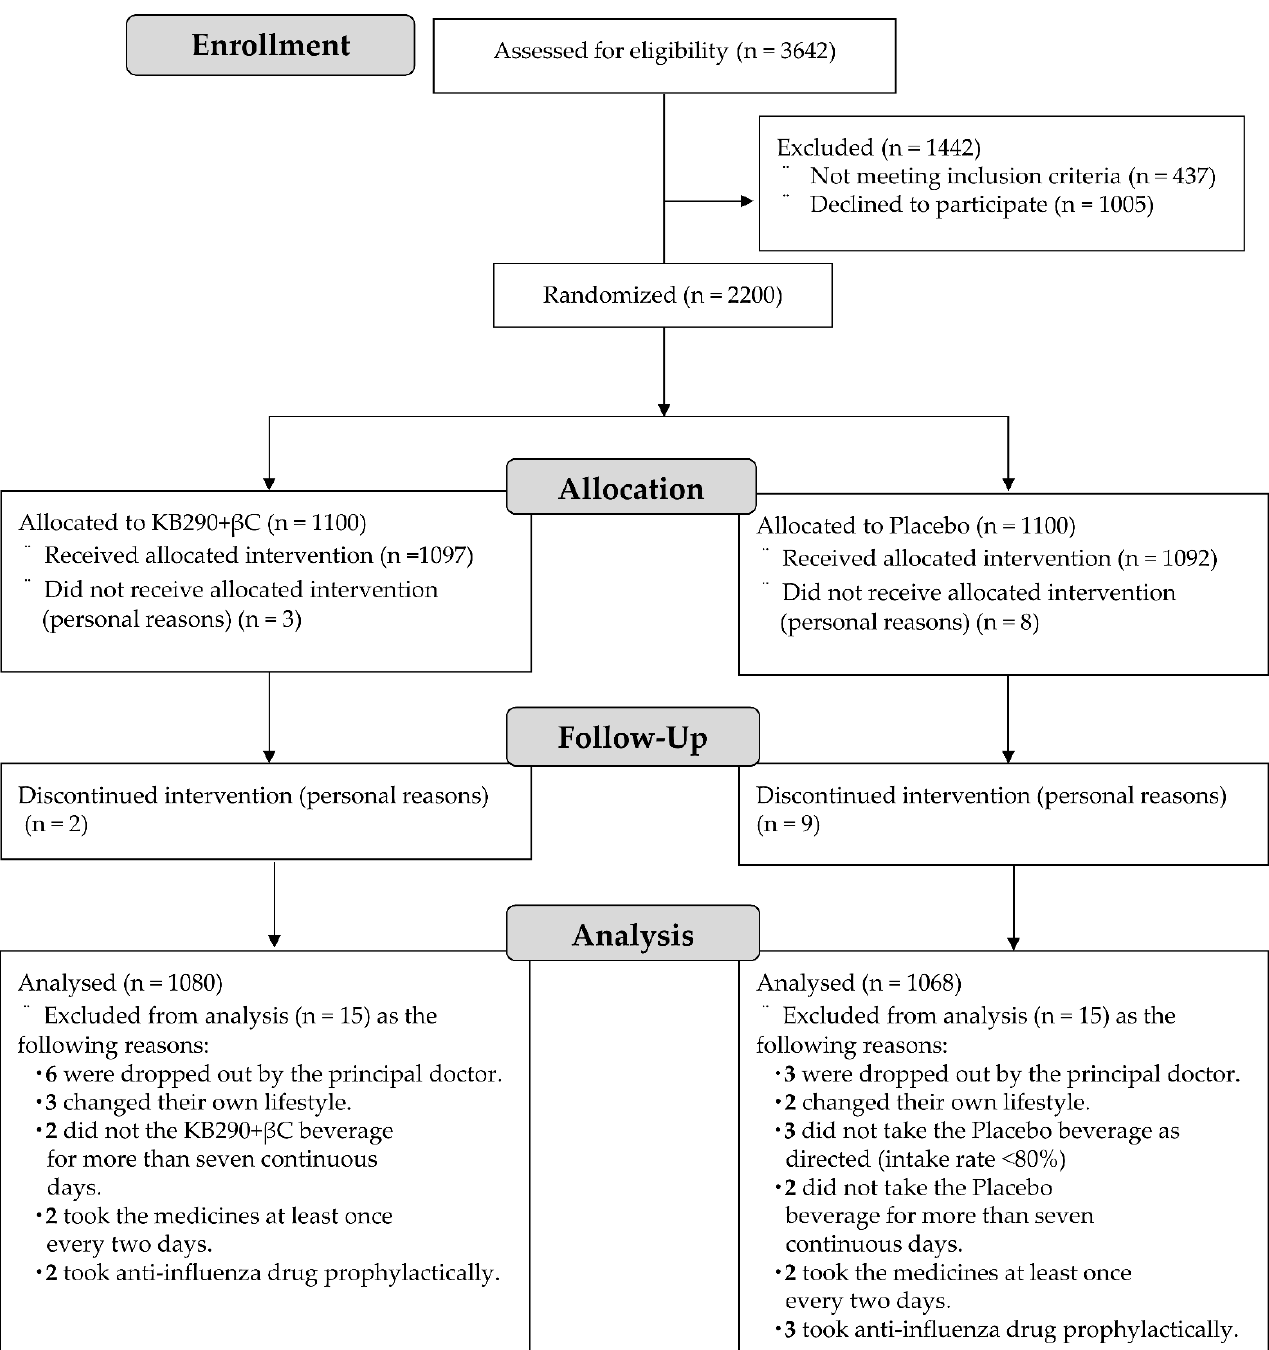
Figure 2. Flowchart of trial subjects. PP: per protocol analysis.